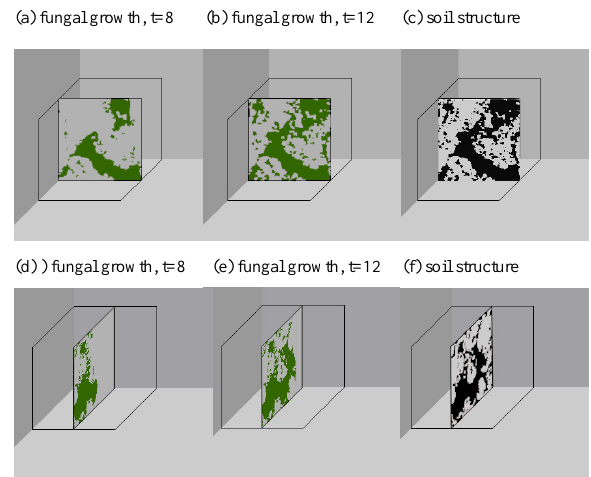
Fig. 5. 2-D slices through the z axis ( a–c , perpendicular to the direc- tion of spread) and x axis ( d–f , in the direction of spread) showing biomass occupancy at t=8 (a, d, halfway the time required to spread through the entire volume), t=12 (b, e, at the time the colony had spread to the opposite side of the subsample), and corresponding pore space (c, f) where solid – gray, pore space – black for a sample at a bulk density of 1.6g/cm 3